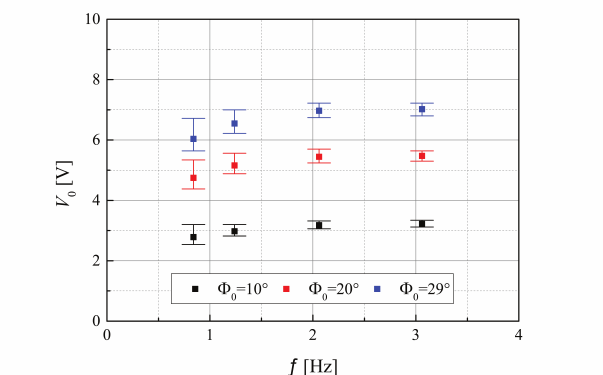
Figure 6. Peak-to-peak voltage of the sensor according to the operating frequency. The maximum, minimum, and averaged peak-to-peak voltages of the repetitive experiments are represented as error bars. The black, red, and blue squares represent the peak-to-peak voltages according to the operating frequency at Φ of 10°, 20°, and 29°,